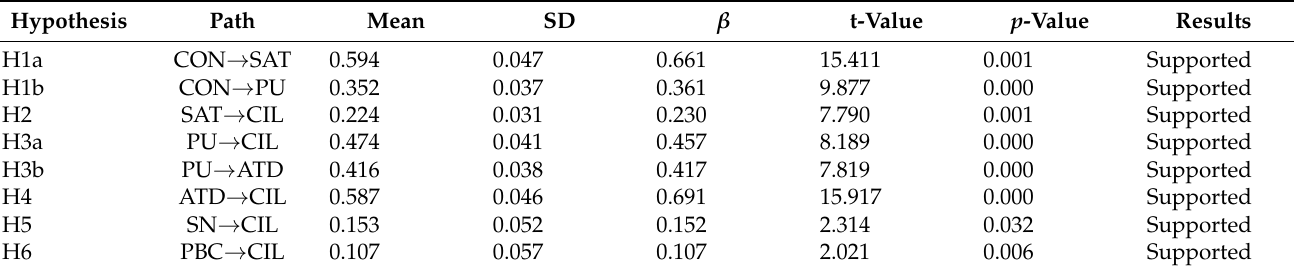
Table 7. Standardized structural